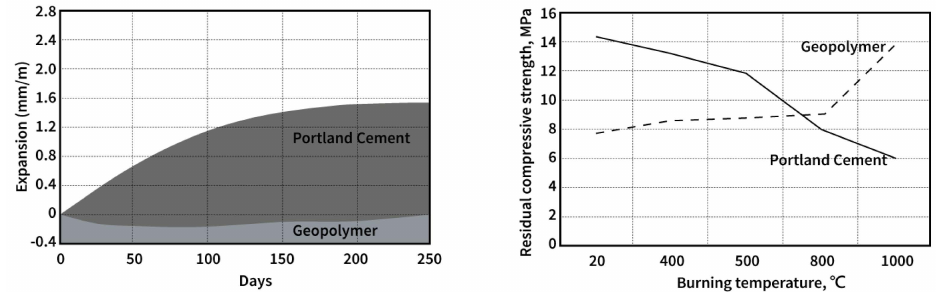
Figure 1. By comparing the alkali aggregate reaction (ASTM C227) between the geopolymer and Portland cement shown after 90 days, the geopolymer was found to have no alkali reaction with long − term durable performance. Even the test sample was under over 1000 ◦ C and the residual compressive strength still retained approximately 14 MPa, proving that the geopolymer combination had better resistance and durable performance